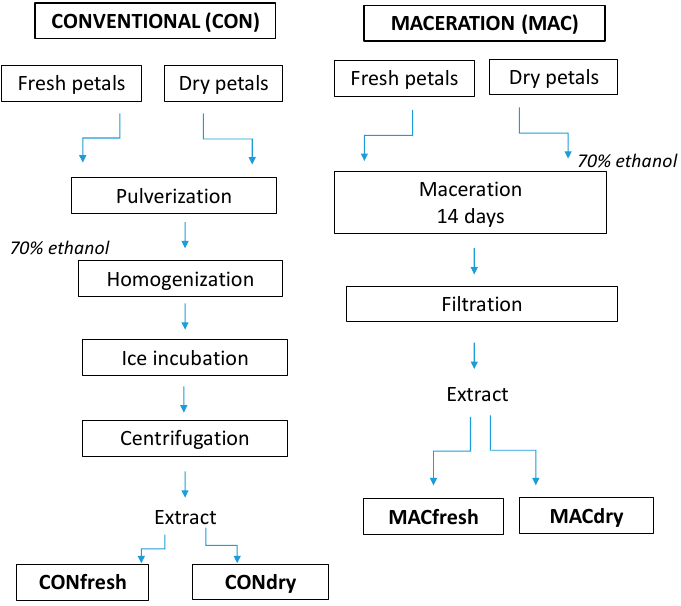
Figure 3. Diagram of the technological procedures for the preparation of liqueurs using maceration and conventional extraction of Rosa rugosa fresh and dry petals.